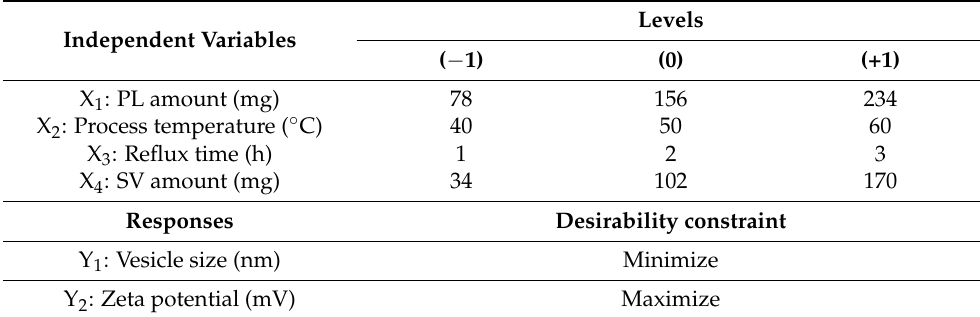
Table 1. Independent variable levels and response constraints employed in the four-level Box– Behnken design for the optimization of QRT-PHM-SV formulations.